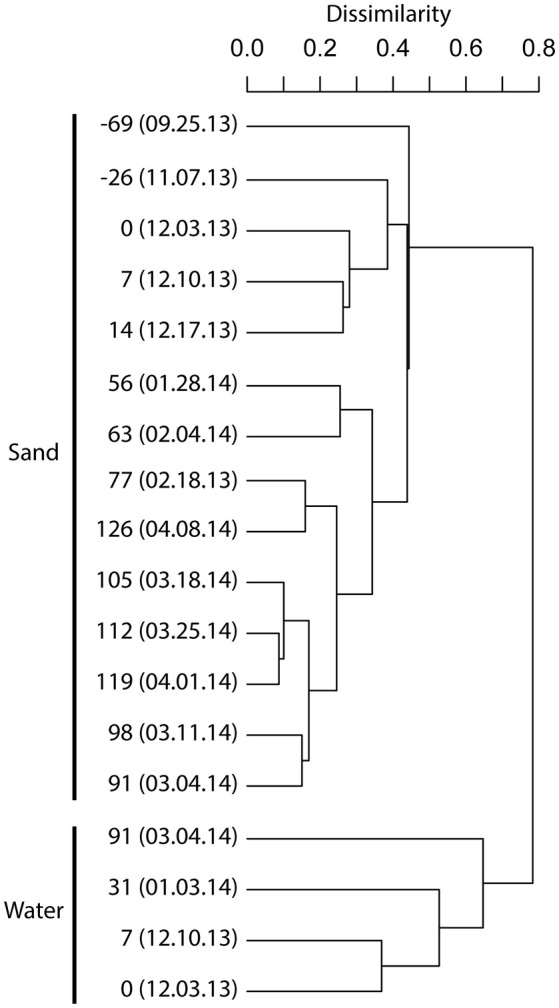
Dendrogram illustrating the bacterial community composition relationships among biofilter sand and biofilter water samples. A complete-linkage dendrogram is depicted from Bray–Curtis sample dissimilarity relationships based on Minimum Entropy Decomposition node distributions among samples (V6 dataset). The leaves of the dendrogram are labeled with the day count, where 0 represents the beginning of a fish rearing cycle. Negative numbers are days prior to a new rearing cycle. The day count is followed by the date sampled (mm.dd.yy). See Table S1 for sample metadata.